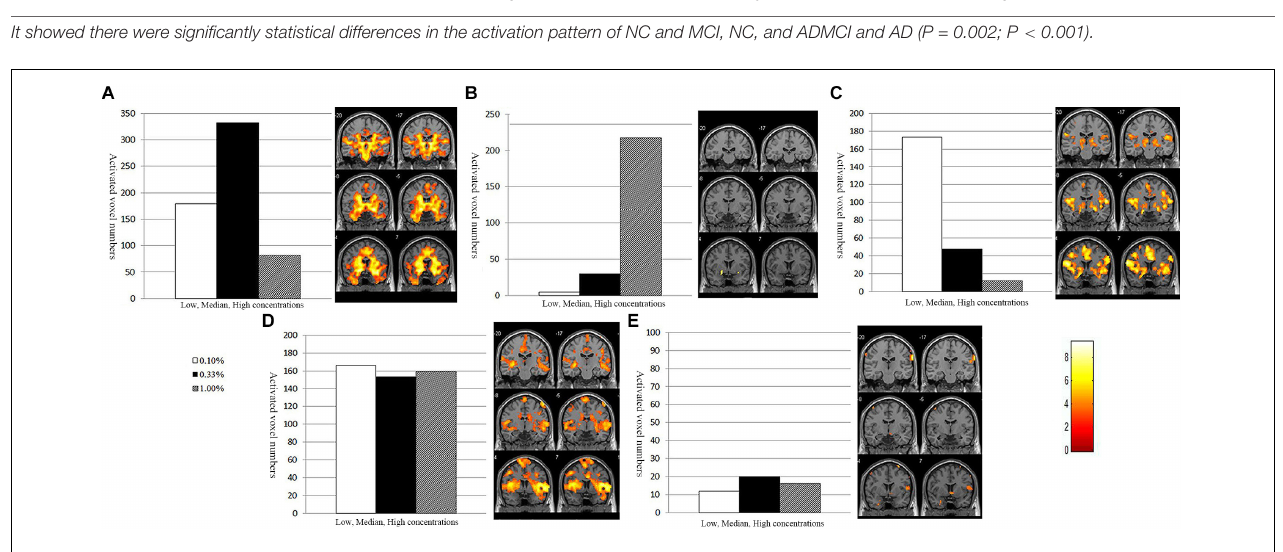
FIGURE 5 | Different types of activation pattern and POC activation map. (A) Ascending-descending type. Bilateral POC activation was low at the low beginning, increased at the median, but decreased at the last high concentration. (B) Gradually ascending type. The POC activation showed a continuously increasing tendency as the concentration increased. (C) Gradually descending type. Bilateral POC activation was gradually decreased with the increase of odor concentration. (D) High plateau type. Bilateral POC activation remained at high level at all three different concentrations. (E) Low plateau type. Bilateral POC activation is little at three different concentrations. The A, C, D showed olfactory habituation and normal activation on the activation map, whereas the B, E implied an impaired olfactory